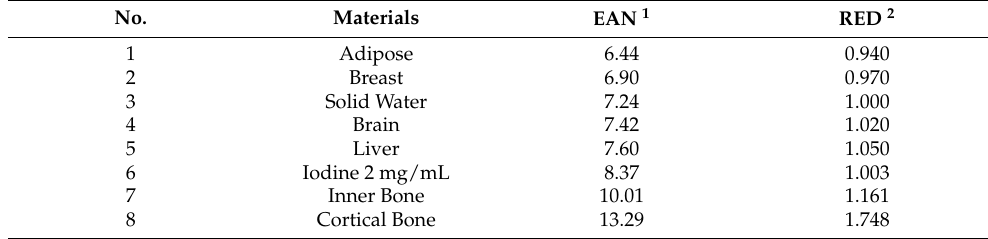
Table 1. Eight materials for stoichiometric calibration, the type of material, relative electron density, and effective atomic number are